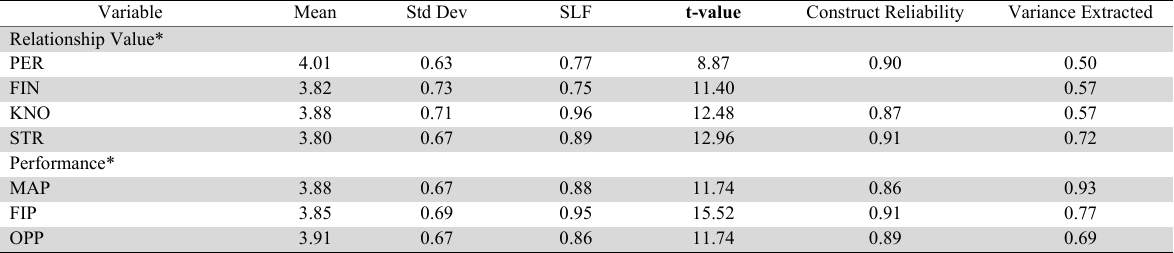
Descriptive statistics and measurement model evaluation